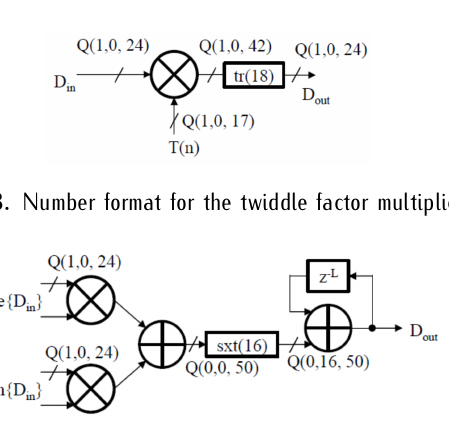
Figure 12. Number format for the butterfly additions.